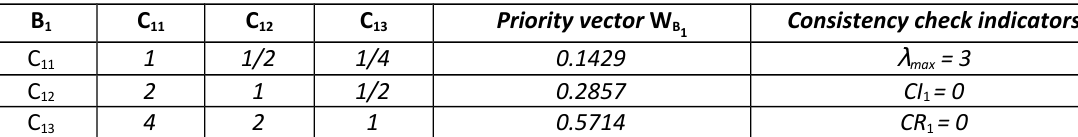
and its consistency check 1